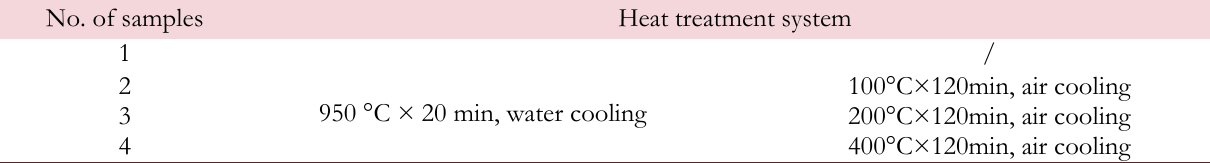
Table 1: Heat treatment system of experimental